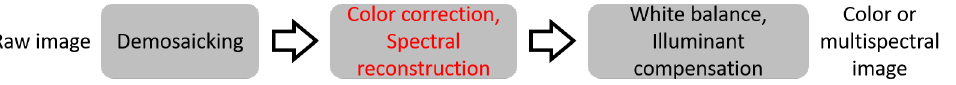
Figure 1. Common linear processing chain in an imaging